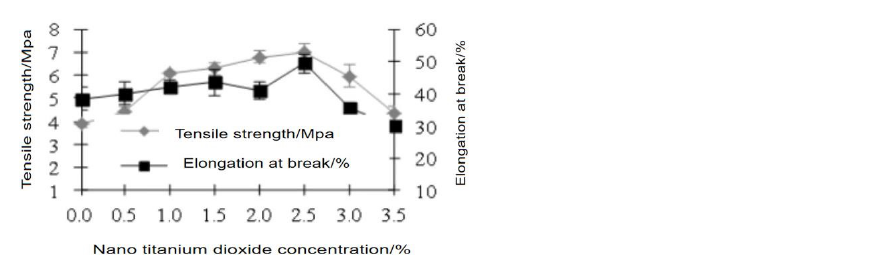
Figure 1. Effects of nano-TiO 2 concentration on tensile strength and elongation rate of the film.